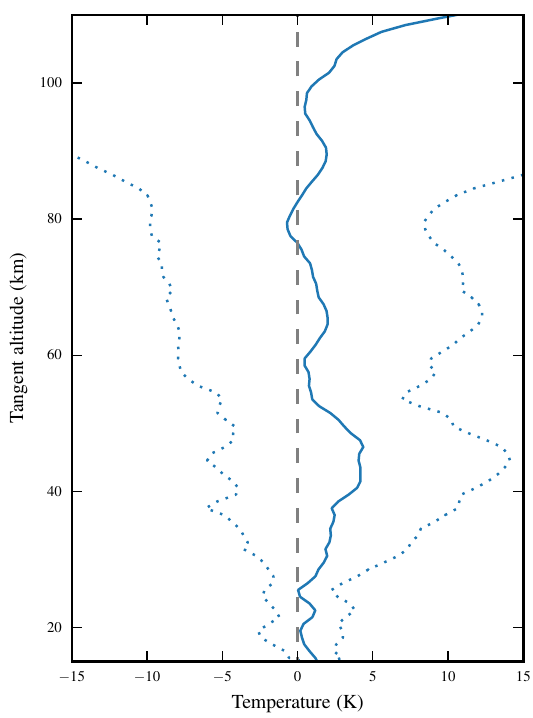
Figure 6. Mean and standard deviation of the differences in re- trieved temperature between GGG and ACE-FTS v3.5 retrievals (GGG − ACE) for all 129 occultations in Fig. 5. The largest differ- ence occurs near 40km and is mostly attributed to the Arctic winter set, Fig.